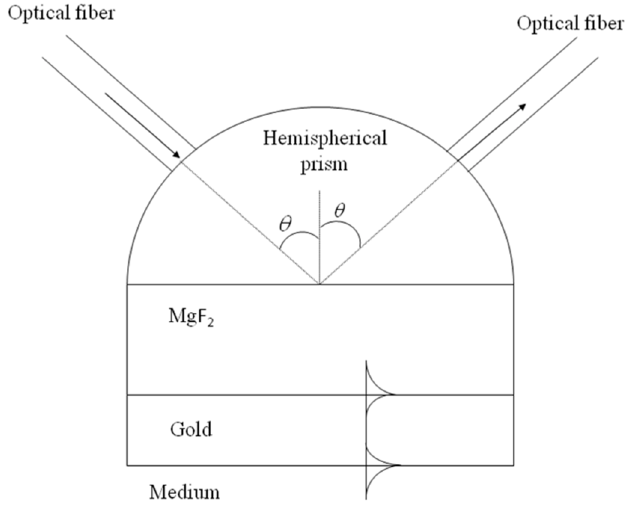
Figure 1. Scheme of the plasmonic sensor. On the left part of the hemispherical prism, the optical fiber transports the incident radiation and on the right, another optical fiber collects the reflected radiation. Also, the surface plasmon polaritons (SPP) are shown propagating through the MgF 2 -gold and gold-medium interfaces.